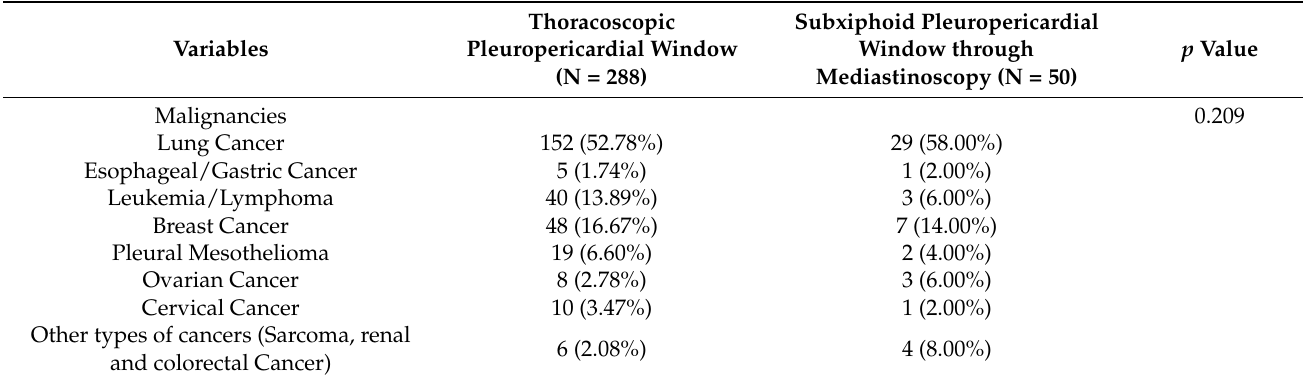
Table 2. Cancer types of patients by surgery